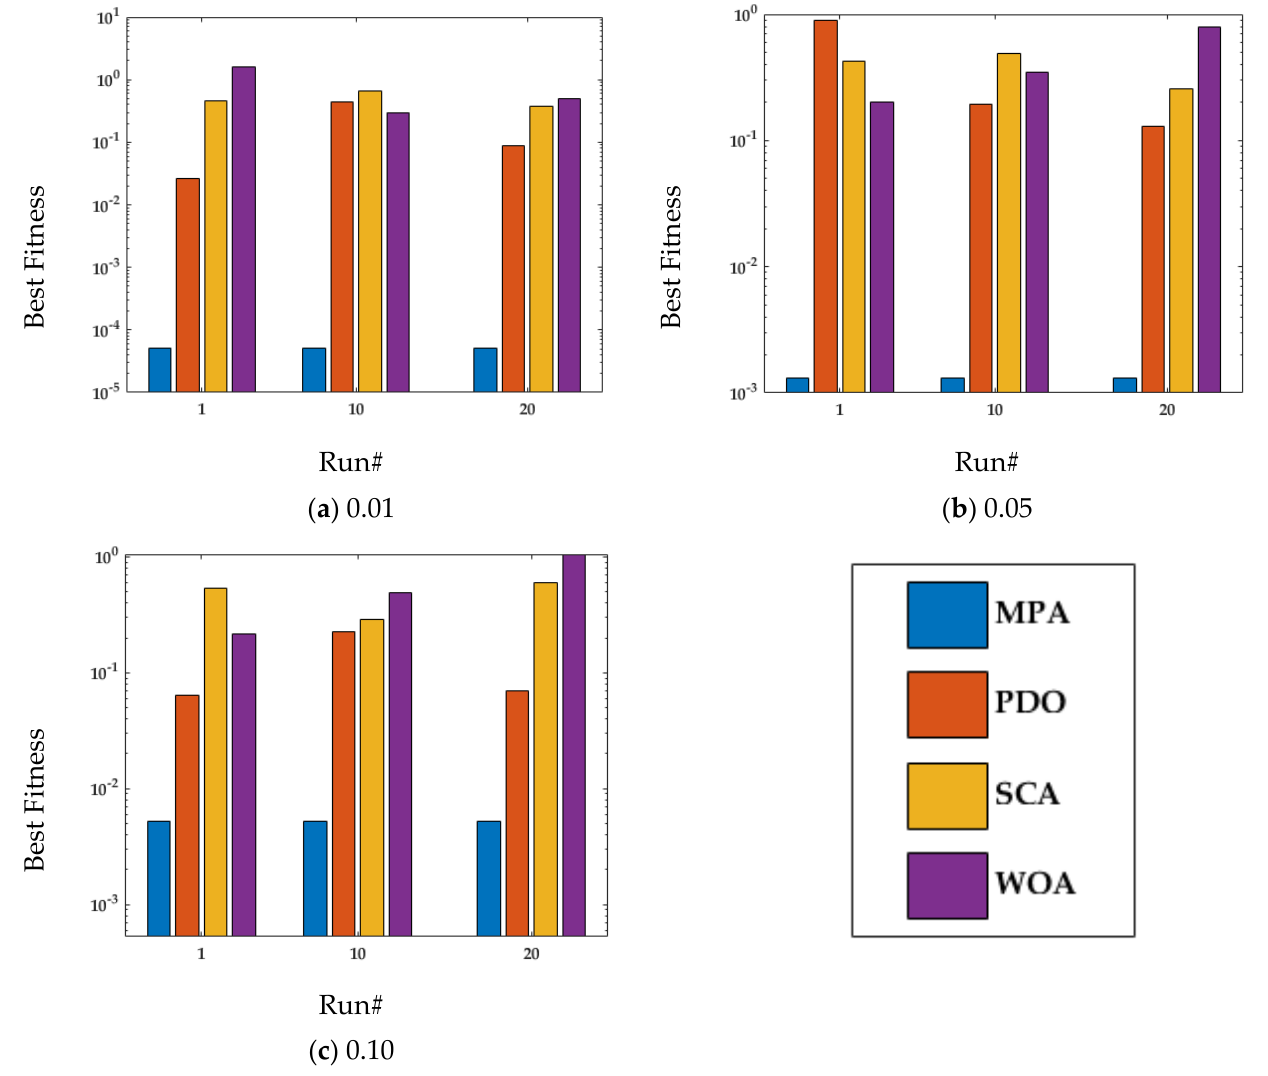
Figure 11. Run# fitness comparison of MPA with PDO, SCA, and WOA at Np = 50 and T = 500 for case study 2.